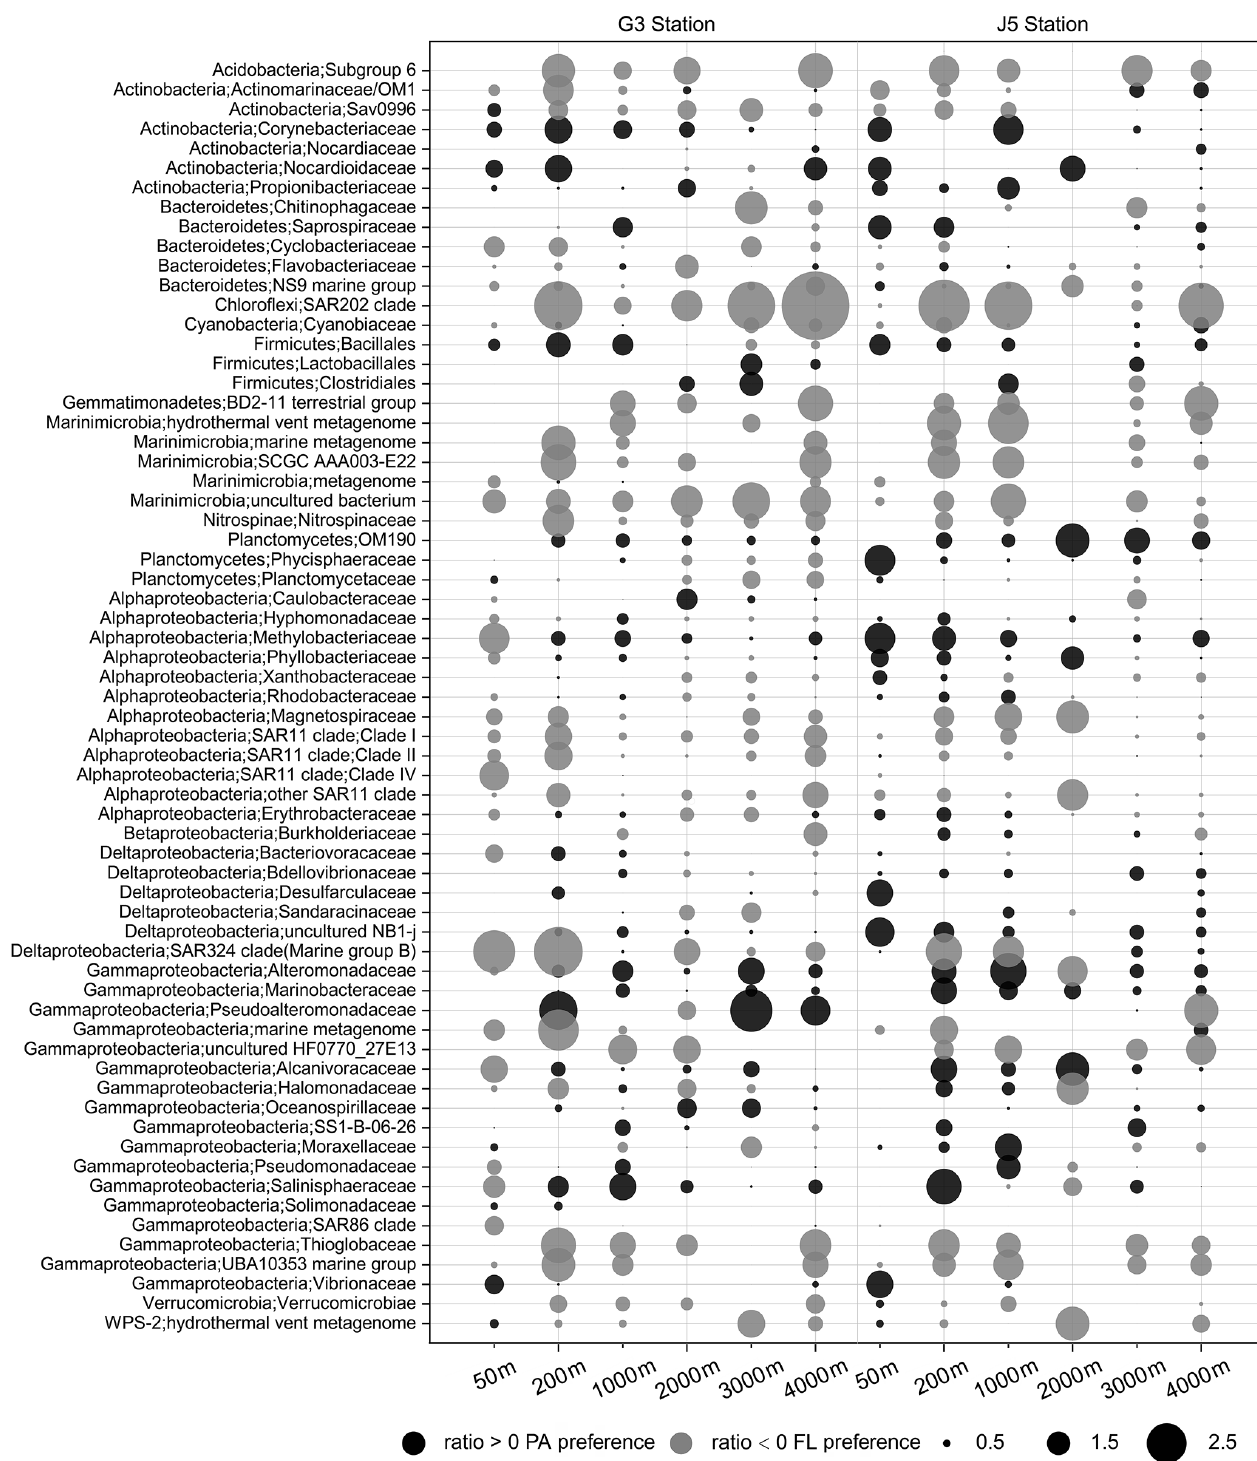
Figure 8. Odds ratio for each of the families with relatively abundant proportions in each sample. Dark grey bubbles represent the clades with a positive odds ratio, meaning the preference of the PA lifestyle. Light grey bubbles represent the clades with a negative odds ratio, which is indicative of the FL preference. Scale is shown at the